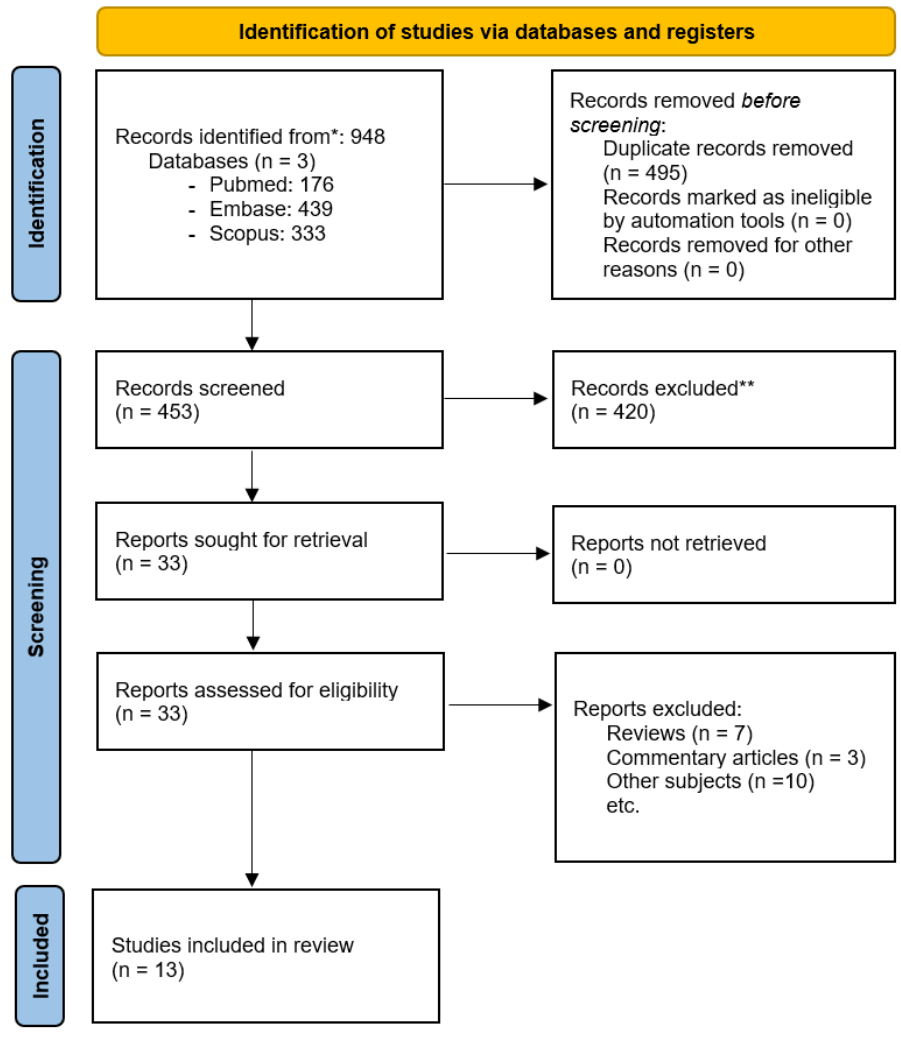
Figure 1. Search strategy—PRISMA flow diagram. * Consider, if feasible to do so, reporting the number of records identified from each database or register searched (rather than the total number across all databases/registers). ** If automation tools were used, indicate how many records were excluded by a human and how many were excluded by automation tools.